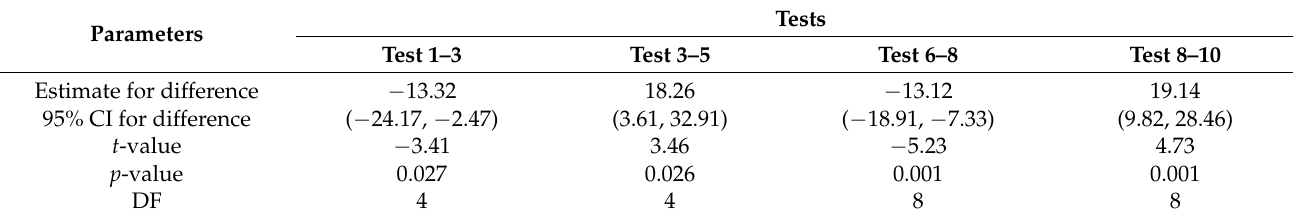
Table 17. t ‐ test results for temperature outliers.